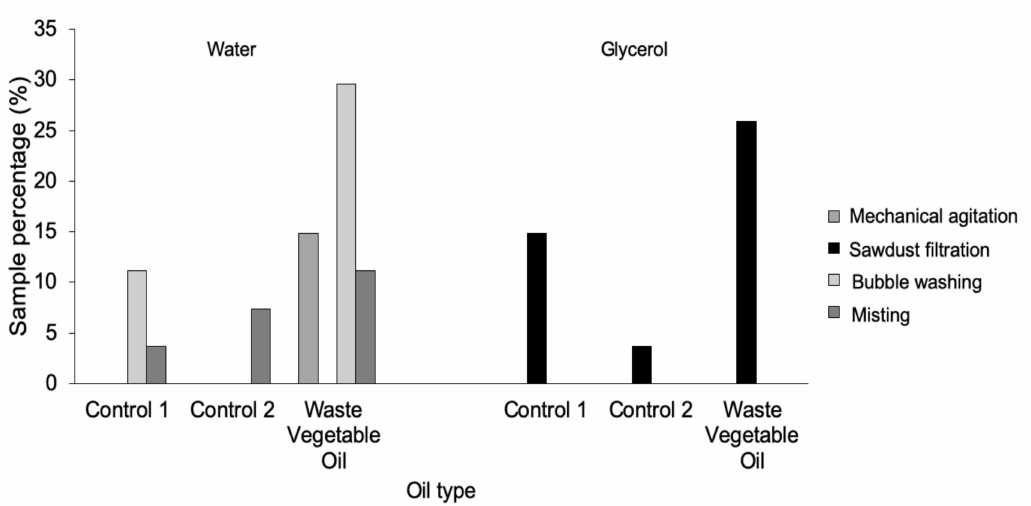
Figure 6. Residual contaminant presence in biodiesel